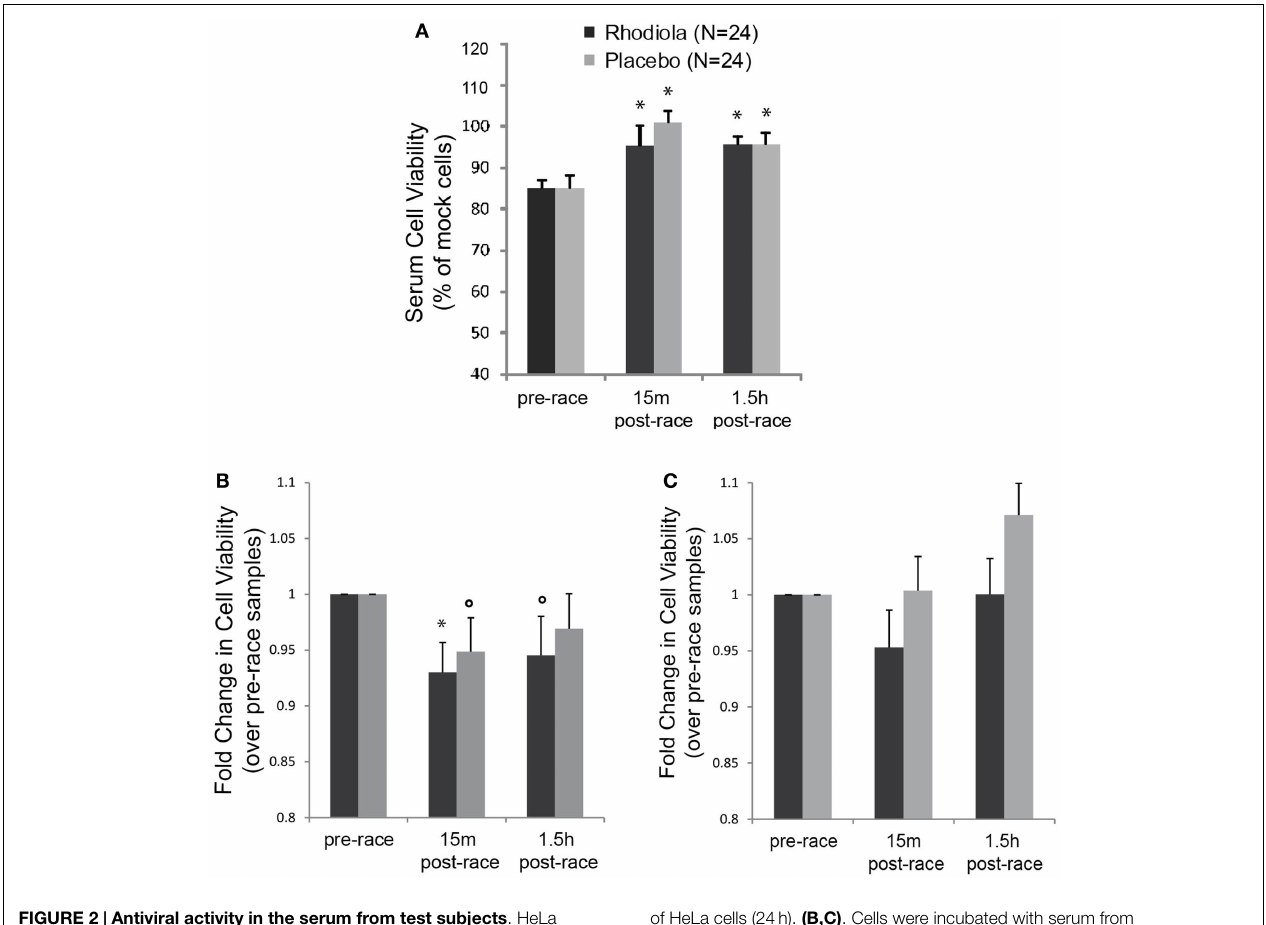
FIGURE 2 | Antiviral activity in the serum from test subjects . HeLa cells were infected with serum from Rhodiola rosea or placebo- supplemented subjects for different times and infected with rwt virus. Cell viability was measured by MTT assay. Controls included cells infected with virus alone or incubated with serum alone. All data were normalized to mock-infected cells. (A) Impact of serum alone on viability